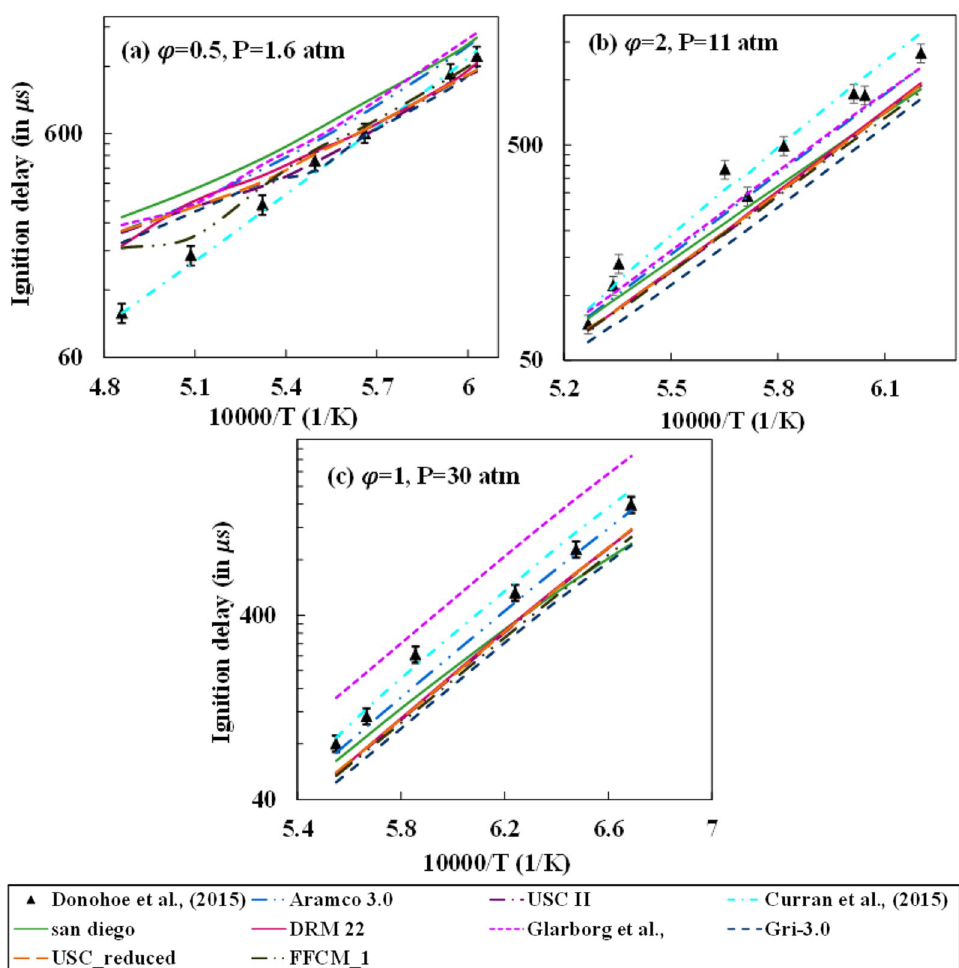
Figure 1. Comparison between different mechanisms for no steam dilution and CH 4 /Argon/O 2 mixtures with 98% Argon by